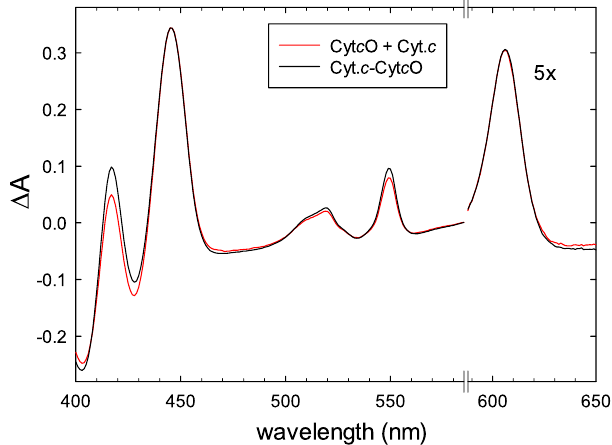
Figure 2. Absorbance difference spectra. A comparison of reduced minus oxidized difference spectra of the Cyt c O-cyt. c complex (black) and the sum of the reduced minus oxidized difference spectra of Cyt c O and cyt. c (red), respectively. Spectra of the oxidized states were recorded first and then the atmosphere in the cuvette was replaced for N 2 after which the samples were reduced with ascorbate (2 mM) and hexaammineruthenium(II) chloride (1 μ M). Reduction of the samples was followed in time by recording spectra over ~2 hours until no further changes were observed. The data to the right of the axis break have been multiplied by a factor of five. The concentrations of Cyt c O and cyt. c were ~3 μ M and ~5 μ M, respectively, in 50 mM HEPES (pH 7.5), 0.05% DDM and 100 µ M